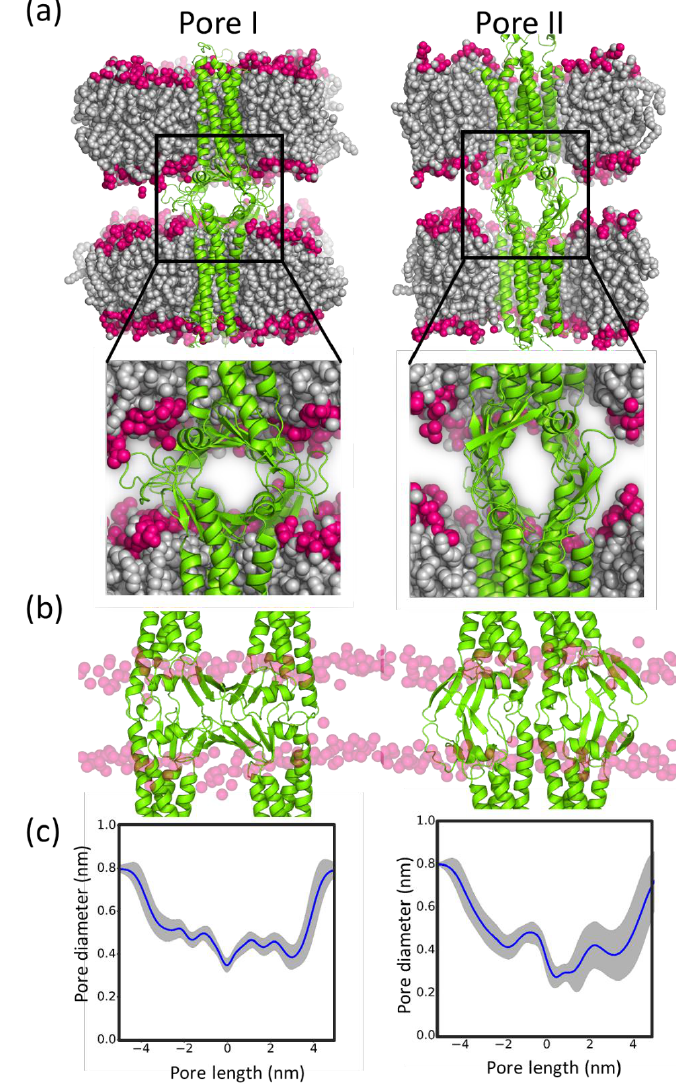
Figure 11. Model for claudin-5 pore I (left) and pore II (right). ( a ) Front-view, ( b ) side-view, and ( c ) pore diameter along the length of the pore.